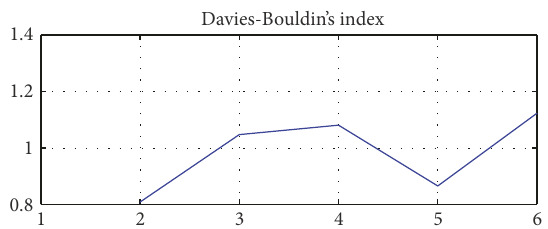
Figure 6: Sum of squared errors using a hexagonal 7 × 5 SOM calculated for each clustering ( 𝑥 -axis: number of clusters/ 𝑦 -axis: sums of squared